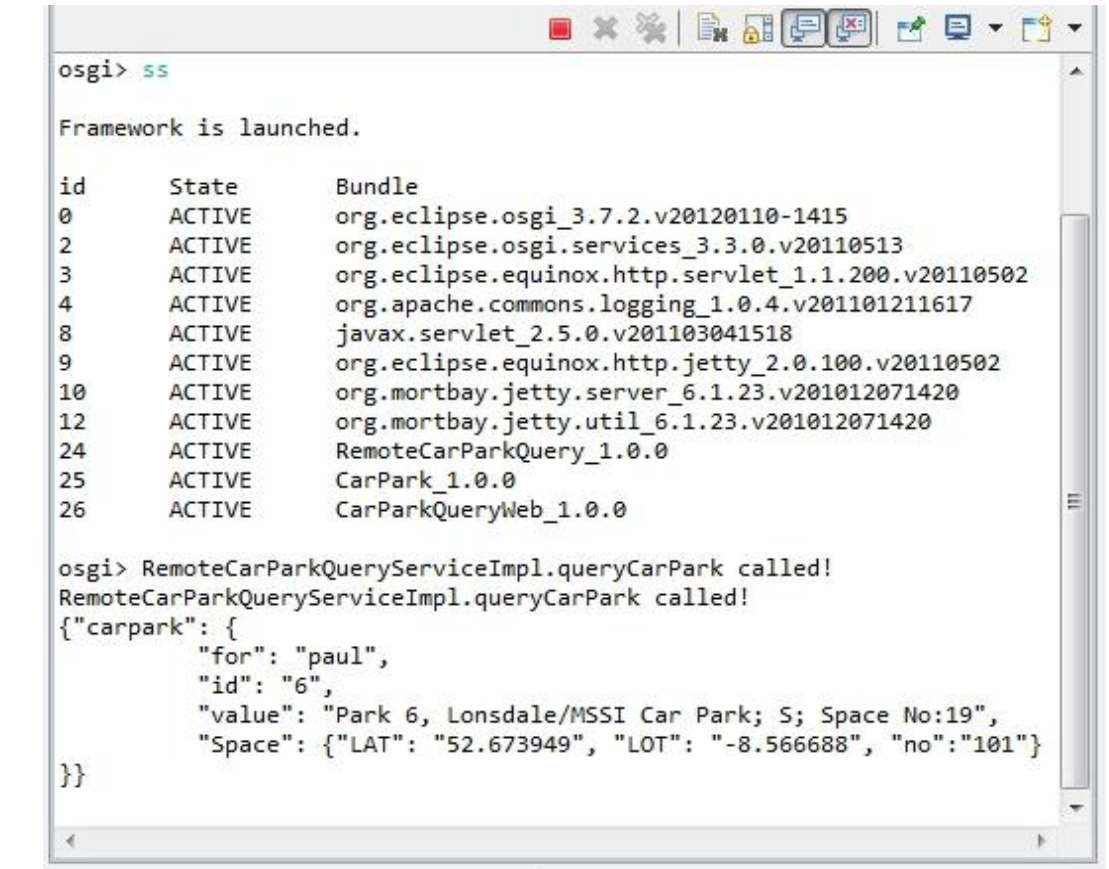
Figure 18. The car parking query service’s OSGi bundle